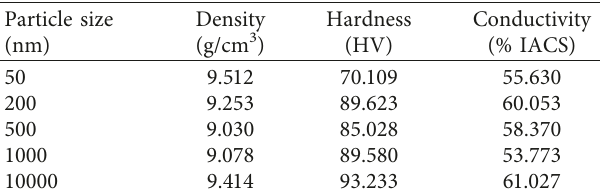
2 /Fe 2 O 3 contact